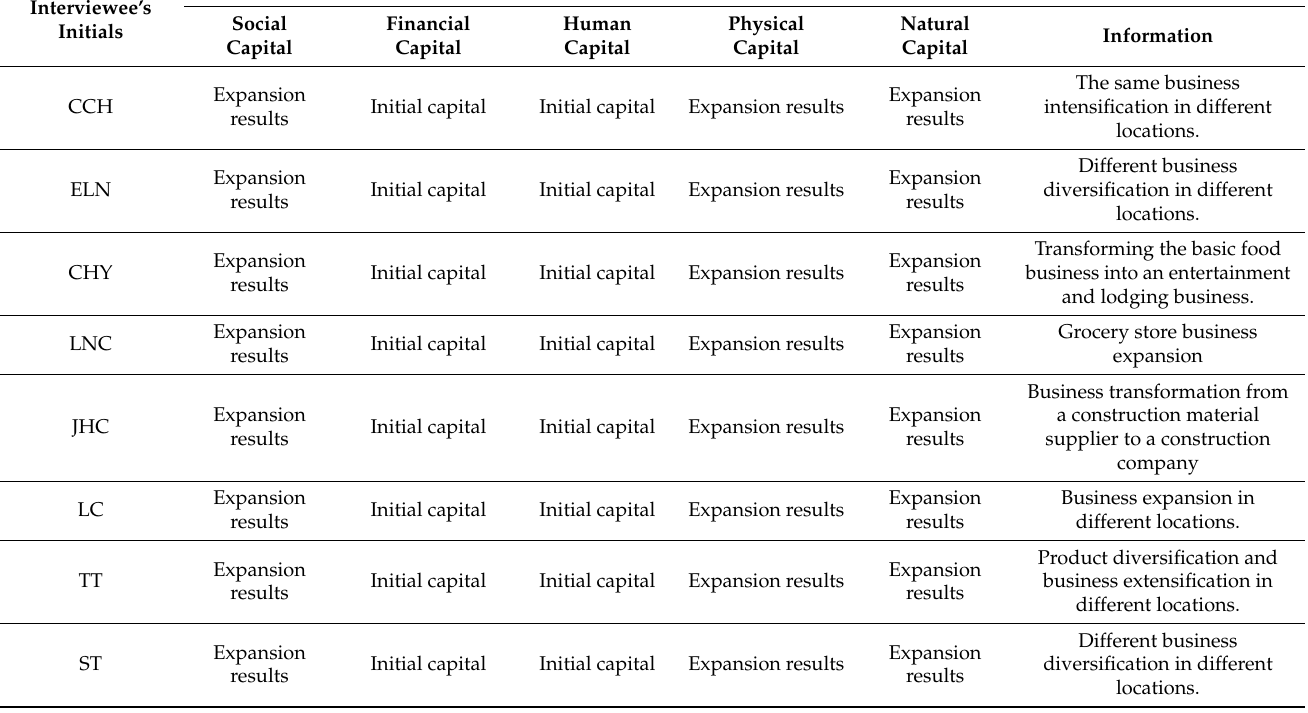
Table 2. Mobility and access to sustainable livelihood supporting resources of migrants from China in